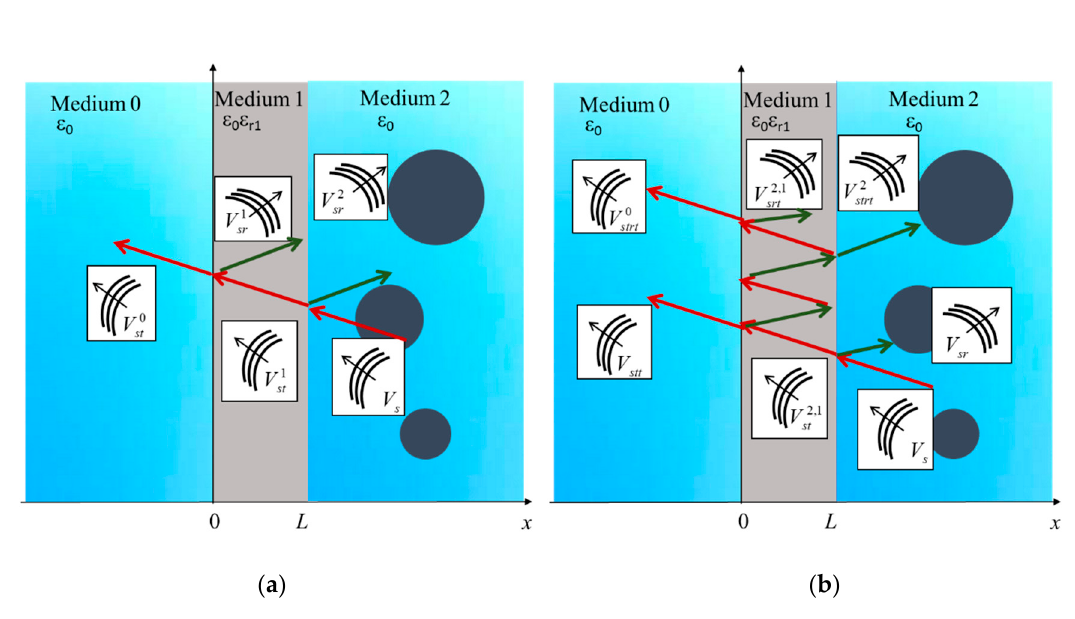
Figure 2. Decomposition of the scattered fields in the scattering by targets in a through-wall Figure2. Decompositionofthescatteredfieldsinthescatteringbytargetsinathrough-wallenvironment: ( a ) non-iterative approach [19] and ( b ) iterative approach